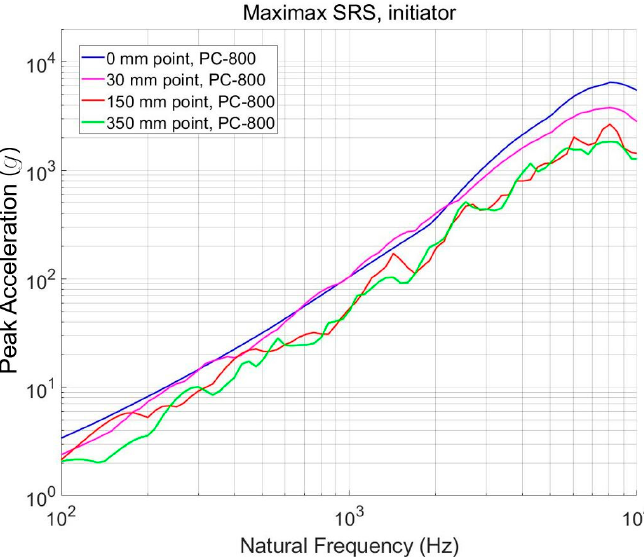
Figure 6. SRS of pyrotechnic initiator (PC ‐ 800).